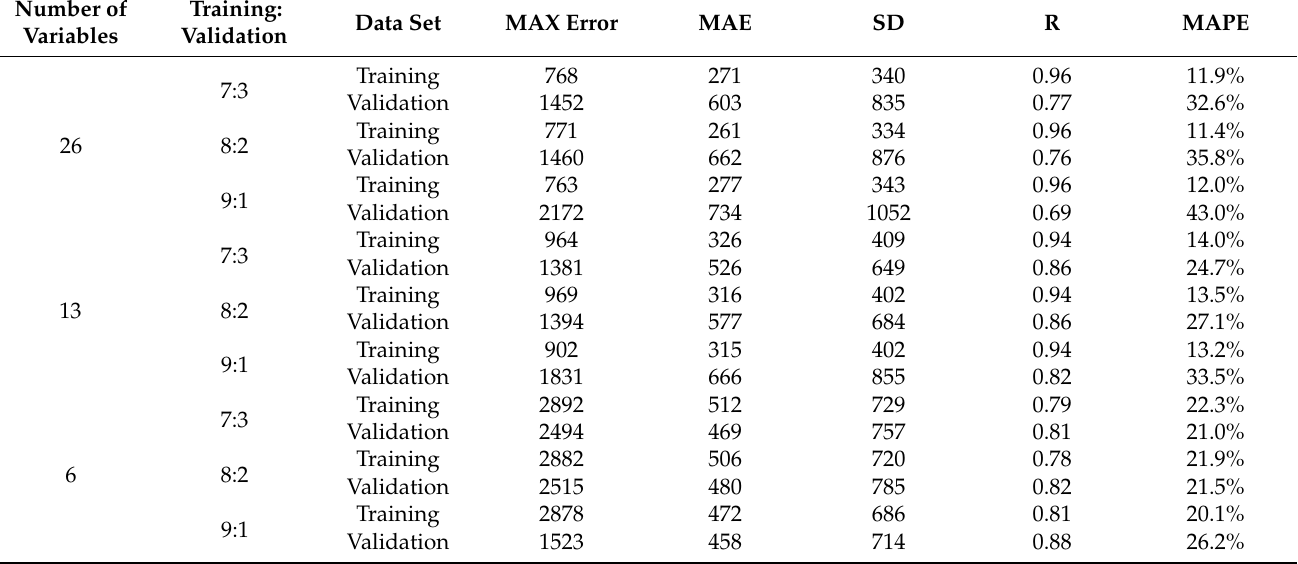
Table A9. Analysis of the results of the MLR model for natural gas